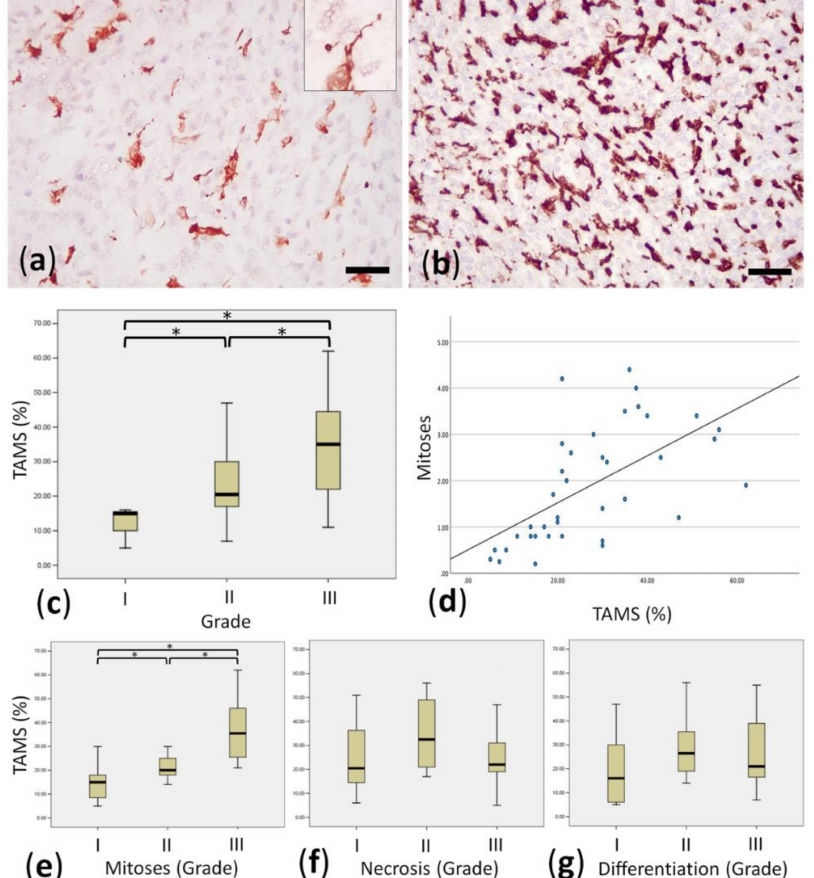
Figure 1. Morphological features of TAMs in canine soft tissue sarcoma, and their associations with grade. ( a ) Iba1-positive TAMs in a case with moderate TAM infiltration. Inset: often TAM exhibited dendritic-like cytoplasmic elongations. Scale bar: 50 microns, indirect immunoperoxidase. ( b ) Iba1-positive TAMs in a case with marked TAM infiltration. Scale bar: 50 microns; indirect immunoperoxidase. ( c ) Significant difference (“*”) in the median of % of TAM infiltration in different Grades. Scale bar: 50 microns; indirect immunoperoxidase. ( d ) Linear correlation between the average number of mitoses in 10 high-power fields (HPFs) and % of TAM infiltration. ( e ) Significant difference (“*”) in the median of % of TAM infiltration in different Grades considering only mitoses as grade component. ( f ) Lack of significant difference in the median of % of TAM infiltration in different Grades considering only necrosis as grade component. ( g ) Lack of significant difference in the median of % of TAM infiltration in different Grades considering only differentiation as grade